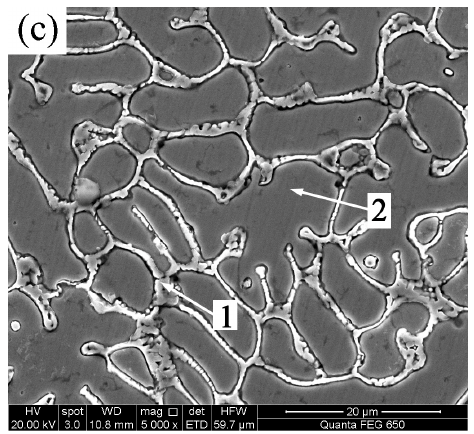
Figure 4. The SEM of Ni-based cladding with different Co contents: ( a ) NiCo00; ( b ) NiCo15; ( c ) NiCo30 (point 1—eutectic structure, point 2—dendrite). Table 2. The EPMA results of the point scan (wt. %).